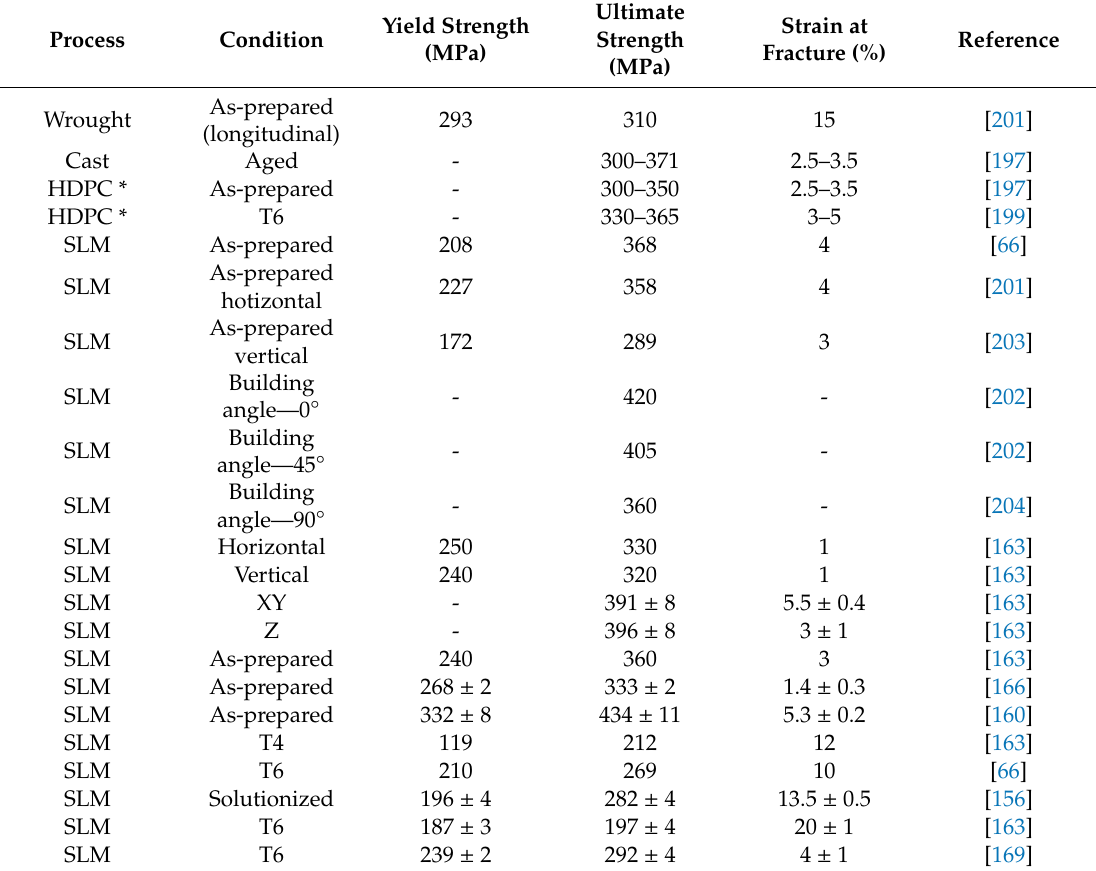
Table 4. Summary of the tensile properties of AlSi10Mg